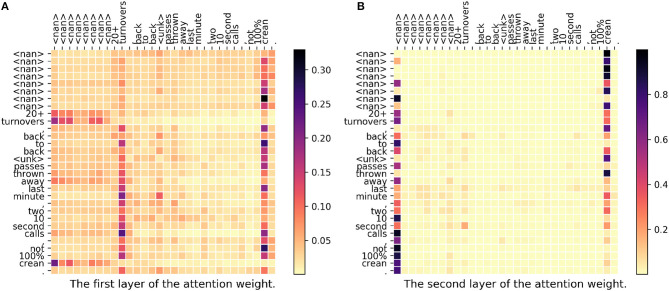
(A,B) The attention weight matrix of our model. <nan> is the padding term since the word length is <30. In this case, only our proposed method correctly predict indianapolis-in097-us. DeepGeo, CNN, and FUJIXEROX predict city of london-enggla-gb, chicago-il031-us, and toronto-08-ca respectively.